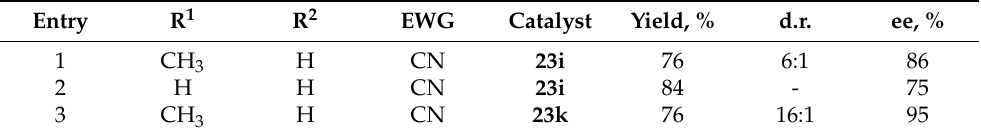
Table 2. Effect of crown ethers in the Michael addition of phosphonoglycine derivative 52 to electron deficient olefins ( 53 ).